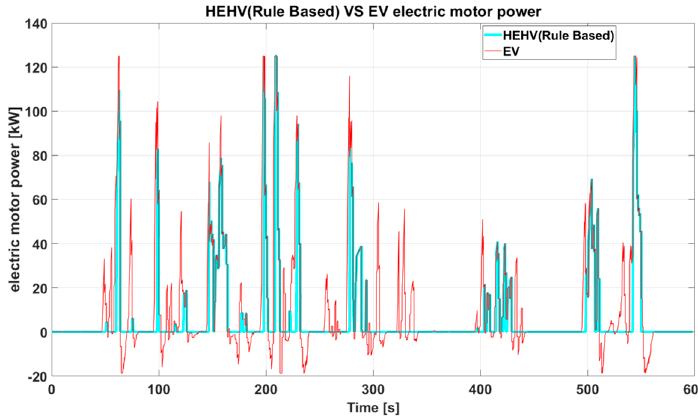
Figure 10. Electric motor power comparison of EV and HEHV.